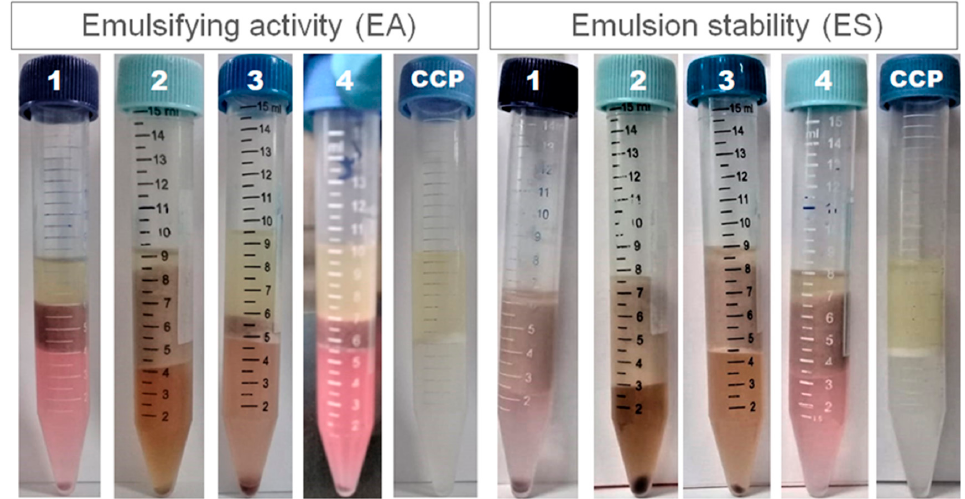
Figure 4. Emulsifying properties. Images of one of the replicates from each